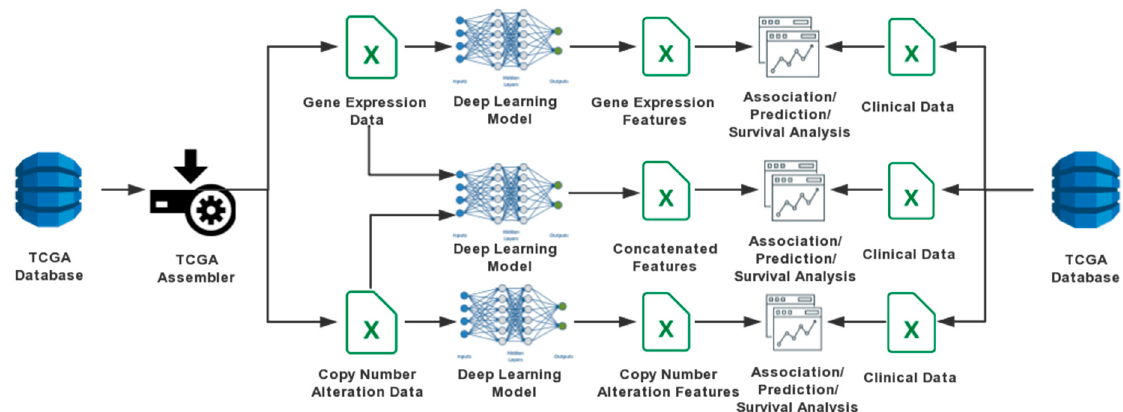
Figure 1. A flowchart illustrating the analysis procedures in this study.